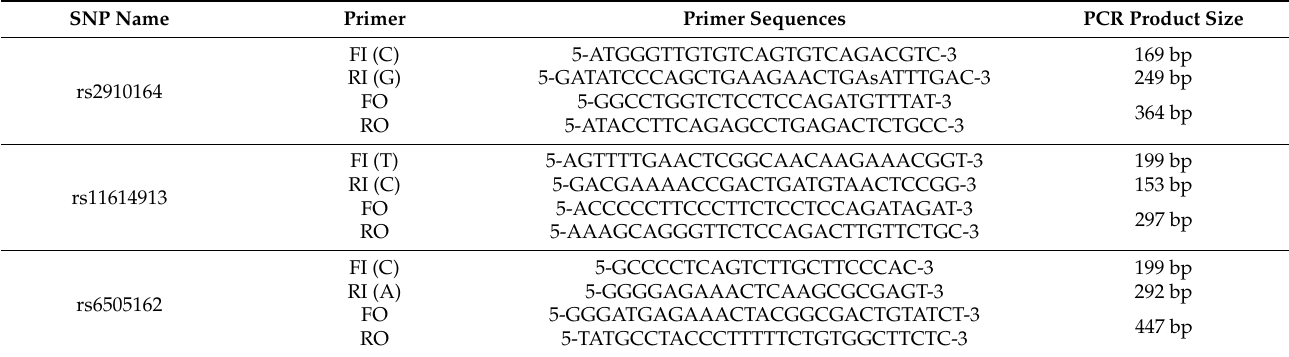
Table 2. Tetra-primer amplification refractory mutation system–PCR (T-ARMS PCR) primers were used for the genotyping of rs2910164, rs11614913, and